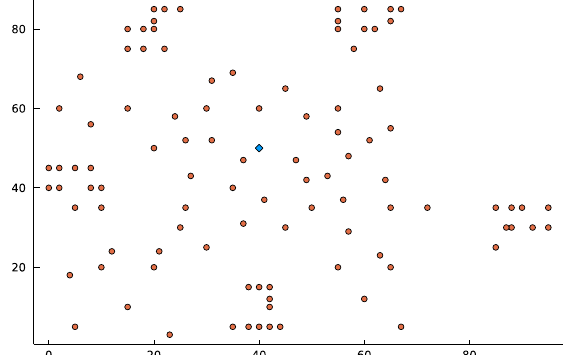
Figure 3. Distribution of customers (represented by circles) in RC-instances with diamond repre- senting the center. Table 2. Literature review for VRPTW with various objective functions and their proposed algo- rithms.